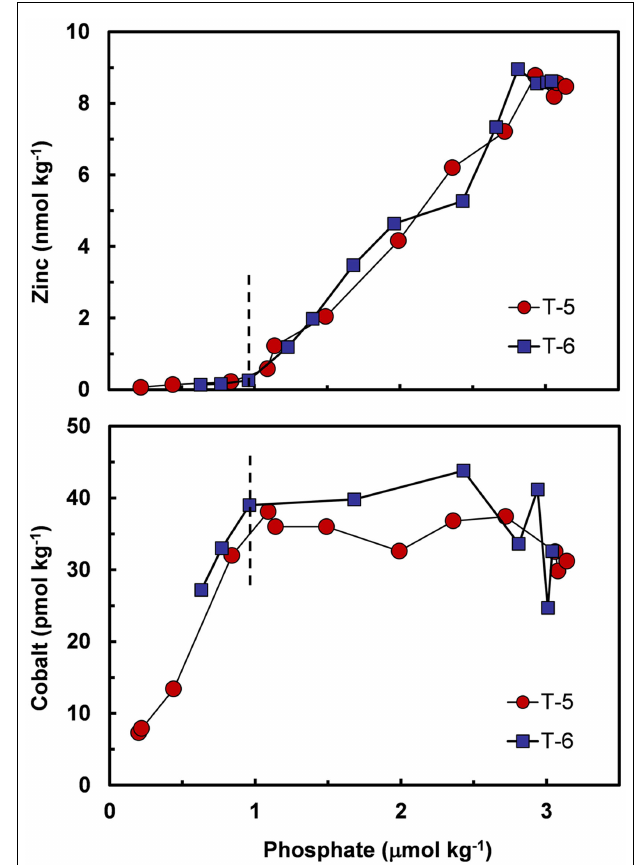
FIGURE 8 | Plots of filterable Zn and Co vs phosphate concentrations at two stations in the subarctic Pacific (StationT-5, 39.6˚N, 140.8˚W and StationT-6, 45.0˚N, 142.9˚W,August 1987). The decrease in zinc with decreasing phosphate is caused by the simultaneous removal of both metals via cellular uptake and assimilation by phytoplankton. Cobalt decreases with decreasing phosphate only after zinc concentrations drop to very low levels ( < 0.2nmolkg − 1 ).This pattern is consistent with metabolic replacement of Co for Zn, as observed in phytoplankton cultures (see Figure 5 ). Data plots after Sunda and Huntsman